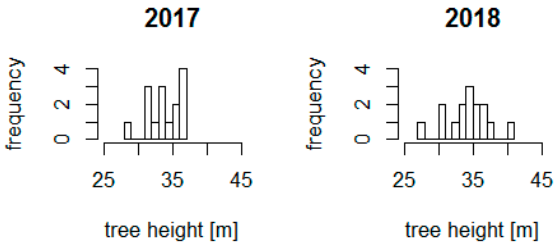
Figure 1. Tree heights of the selected trees in 2017 and 2018, respectively.